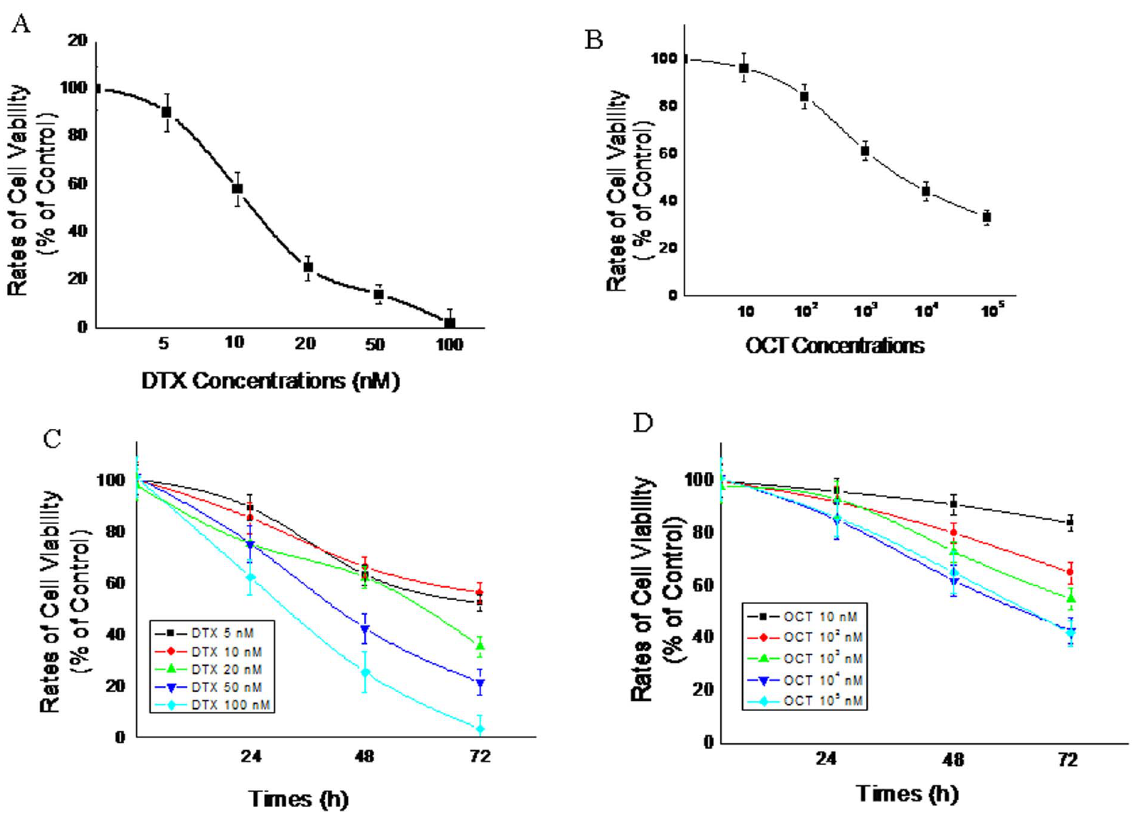
Figure 2. Inhibition of cell growth by different concentrations of DTX (A), OCT (B) after 72 hours incubation and in a time- and dose-dependent manner both of them respectively (C and D) on DU145 proliferation. Cell viability was determined by MTT assay and expressed as a percentage of the control value (mean 6 SEM of three experiments done in triplicate); error bars=SEM (n=6).